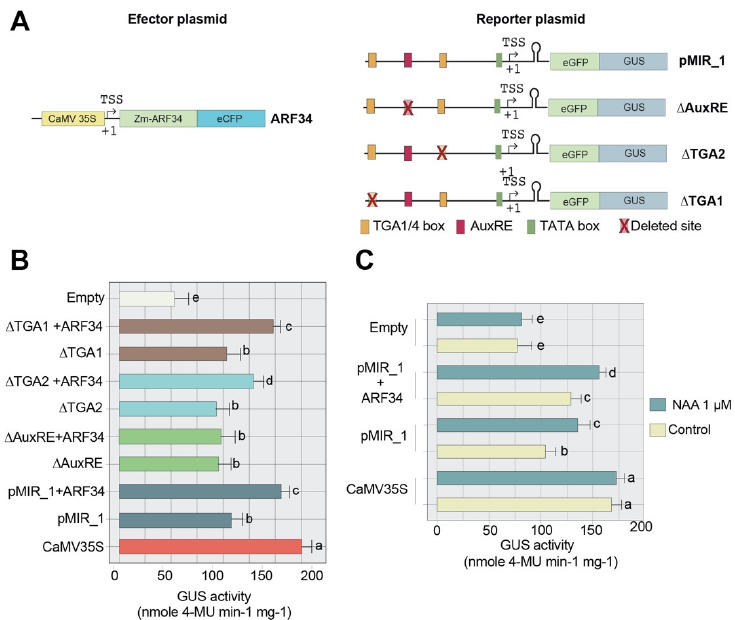
Figure 7. Activation of zma- MIR528a promoter by Zm-ARF34 ( A ) Schematic diagram of the effector and reporter constructs used in the transactivation analysis in maize protoplasts. The effector construct contained the 35S promoter fused to the ORF of ARF34 for constitutive expression. ( B ) Effect of Zm-ARF34 overexpression on the activity of the zma- MIR528a promoter in protoplasts. The pMIR_1, ∆ AuxRE, ∆ TGA2, and ∆ TGA1 constructs were co-transfected with the effector plasmid in maize protoplasts incubated in control conditions. ( C ) Effect of ARF34 and auxin on the activity of the zma- MIR528a promoter. The pMIR_1 reporter construct was co-transfected with the expression plasmid of ARF34 in protoplasts and incubated in the absence (control) or presence of 1 µM NAA. GUS activity was normalized by absolute quantification of transfected DNA for both constructs. Values represent GUS activity determined by fluorometry. CaMV 35S:GUS and a vector lacking a promoter region (Empty) were used as positive and negative controls, respectively. Data represent mean ± S.E.M. of at least three independent experiments with three replicates each ( n = 9). Two-way analysis of variance (ANOVA) and a post hoc multiple-comparison Tukey’s test were used to de- termine the significant difference between transfections and treatments. Bars that do not share at least one letter differ significantly ( p < 0.05) from each other.